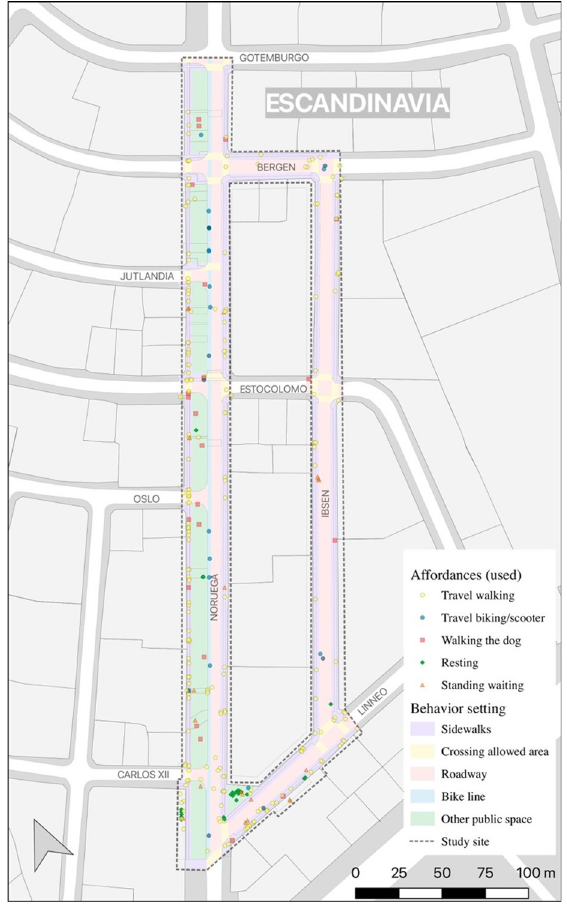
Fig 5. Behavior setting and active affordances. Source : own production over Openstreetmap